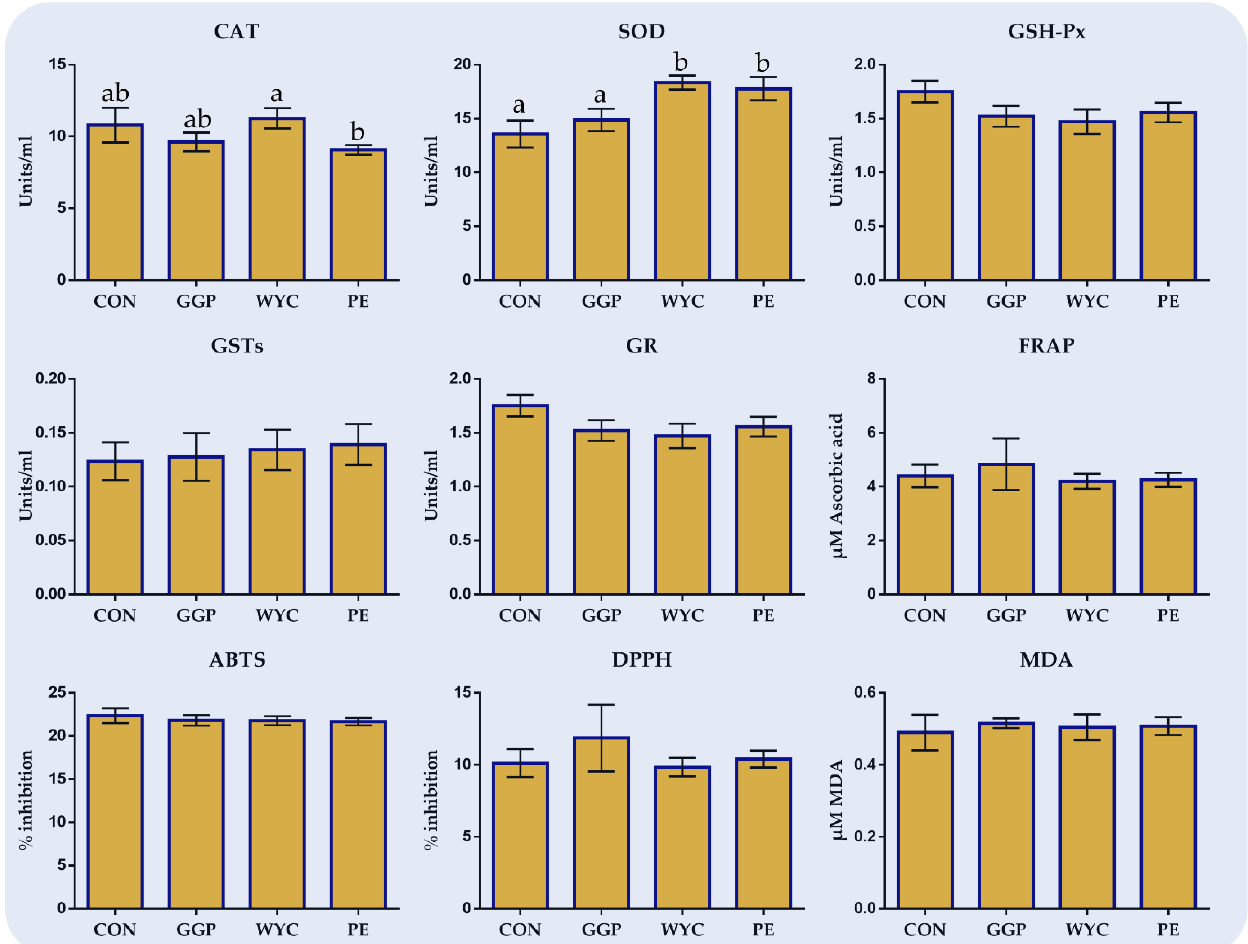
Figure 3. Means ± SEM of total antioxidant capacity, oxidative stress indicators, and enzyme activities (Units/mL) in the blood plasma of broilers fed the four diets (Control; CON, ground grape pomace; GGP, dried wine lees extract; WYC, and grape stem extract included in soluble starch; PE) at 42 days. Bars with different superscript (a, b) between dietary treatments differ significantly ( p ≤ 0.05) according to the analysis of variance (ANOVA) using post hoc multiple range test when appropriate.